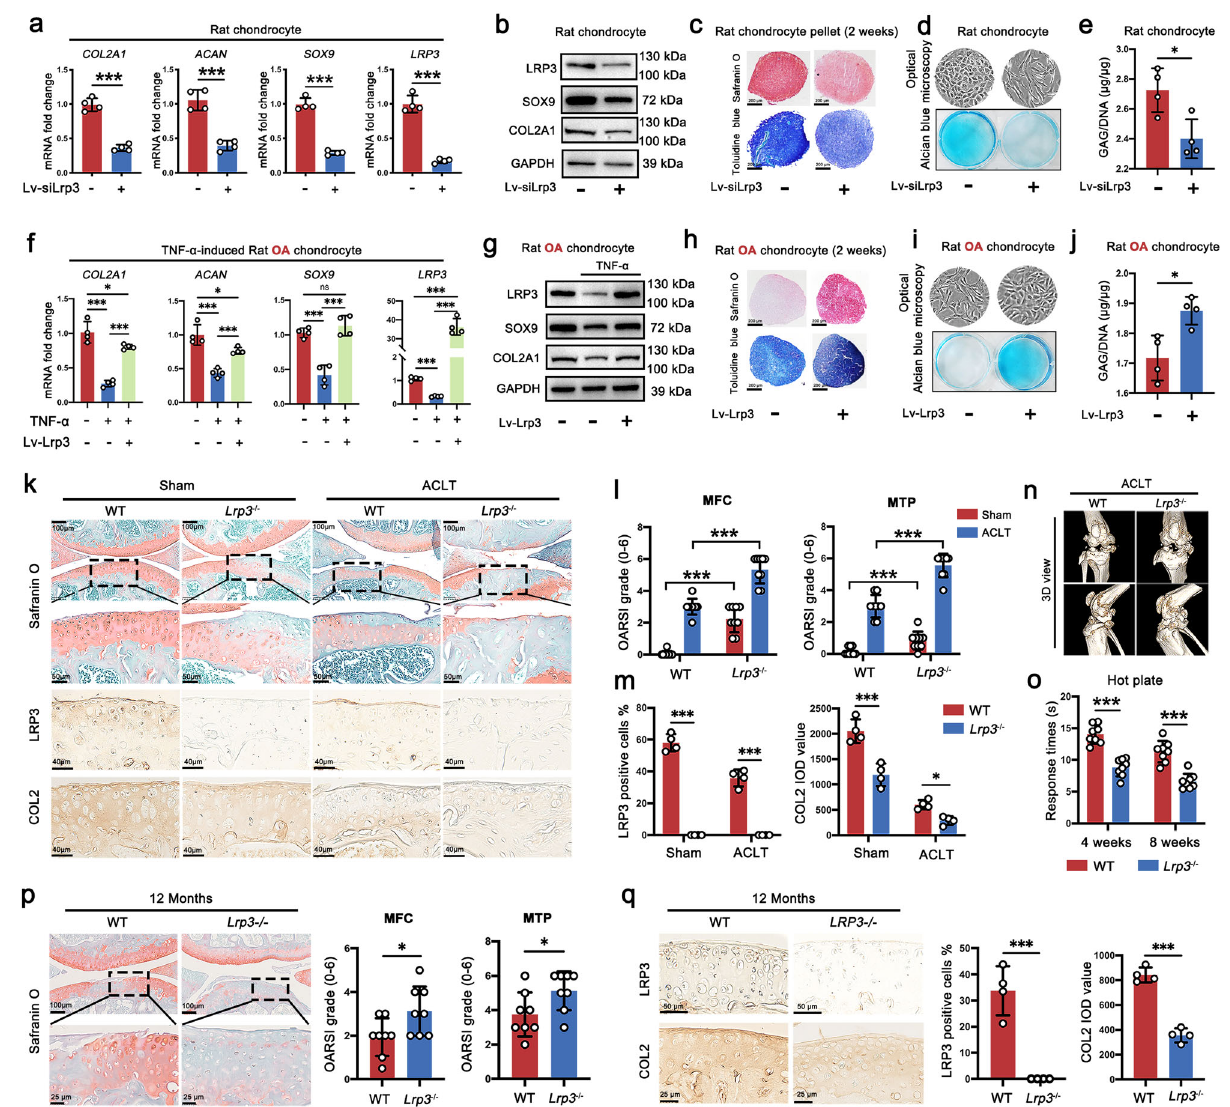
Fig.4|LRP3positivelyregulatesthemetabolismofchondrocytesECM,andthe de fi ciency of LRP3 aggravates the degeneration of knee joint cartilage. a Quanti fi cation of mRNA ( n =4, two-tailed Student ’ s t -test) and b proteins levels ( n =3)inratchondrocytestreatedwithLv-con313( n =4,two-tailedStudent ’ s t -test). c Safranin O and toluidine blue staining of rat chondrocyte pellets treated with Lv- con313 ( n =3). d Optical microscopy, alcian blue staining, and e DMMB assays to examine the glycosaminoglycan expression ( n =4, two-tailed Student ’ s t -test). f Quanti fi cation of mRNA ( n =4, one-way ANOVA) and g proteins levels ( n =3) in TNF- α (20ng/ml)-induced rat OA chondrocytes treated with Lv-con335. h Safranin O and toluidine blue staining of TNF- α (20ng/ml)-induced rat OA chondrocyte pelletstreatedwithLv-con313( n =3). i Opticalmicroscopy,alcianbluestaining,and j DMMB assays to examine the glycosaminoglycan expression ( n =4, two-tailed Student ’ s t -test). k Representativeimagesof safraninO-fastgreen,LRP3, and COLII